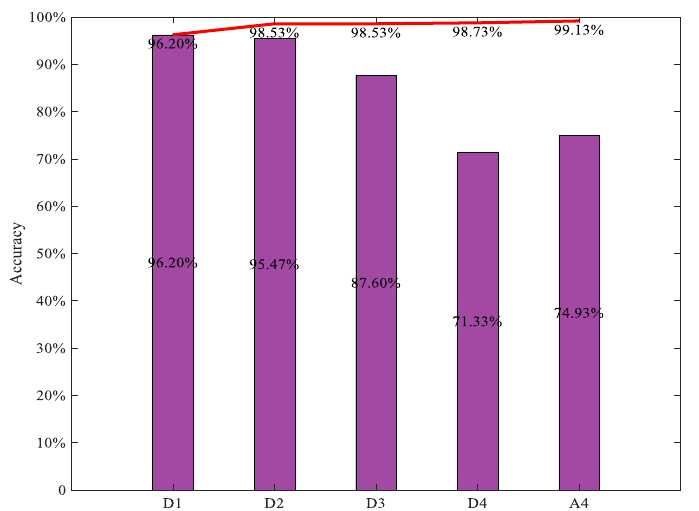
Figure 14. Diagnosis accuracy of integrated CNN using the first n individual CNN. The histogram indicates the diagnosis accuracy of the individual ViT with different TFR maps respectively, the red curve indicates the diagnostic accuracy of the integrated ViT model with the first n TFR maps of subsignals.